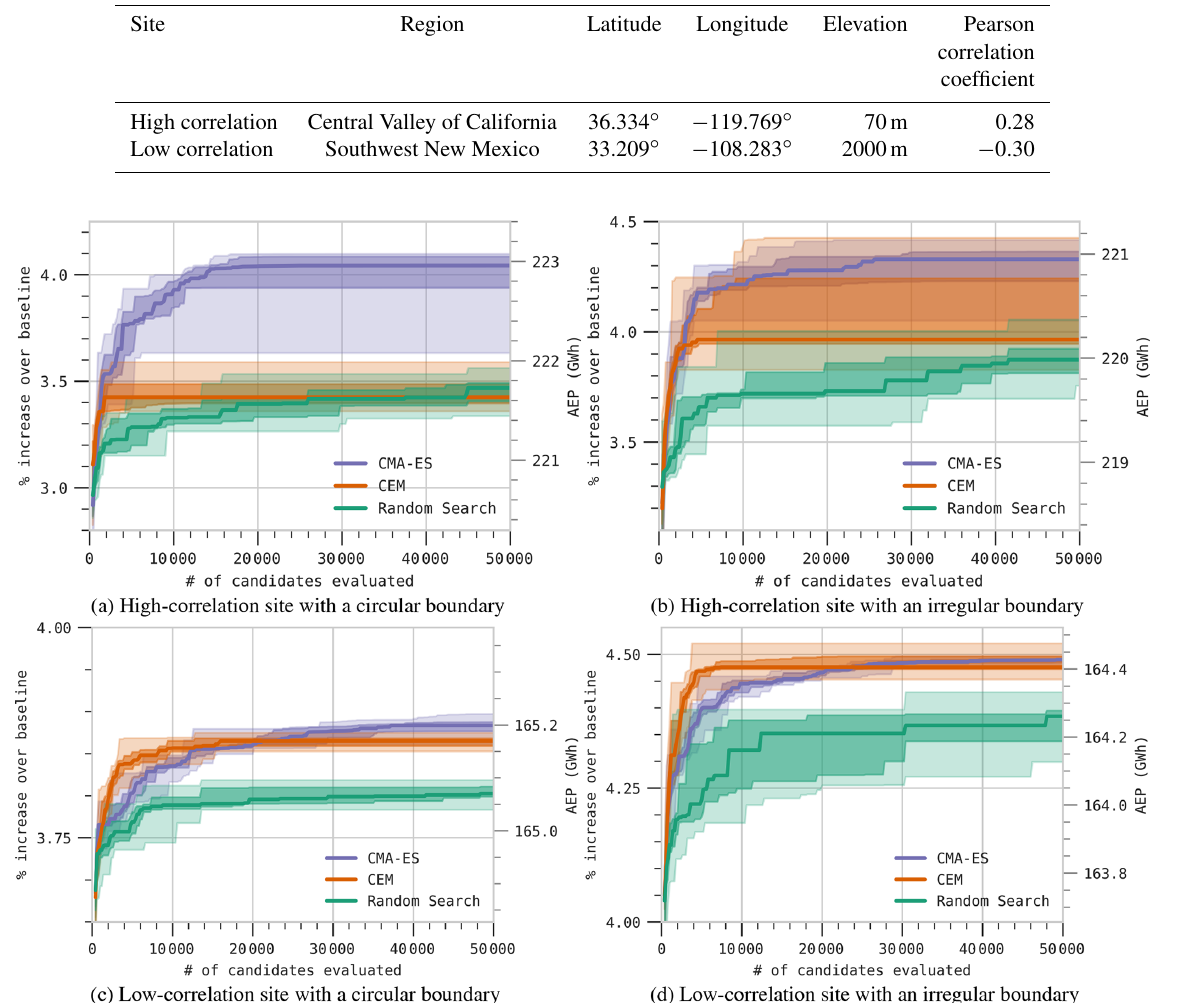
Table 2. Comparison of the two test locations.